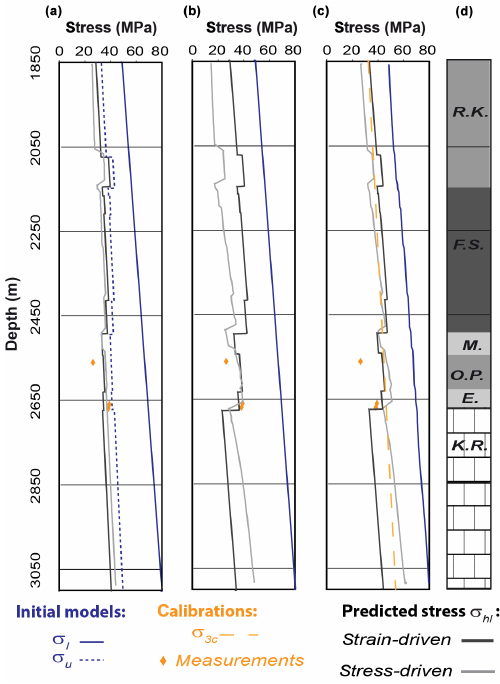
Figure 6. Comparison of the stress- and strain-driven models. Stress predictions for the stress-driven and the strain-driven models for (a) predictive strategies 1 and 5, based on the uniaxial stress and in situ stress measurements; (b) predictive strategies 2 and 6, based on the lithostatic stress and in situ stress measurements; and (c) pre- dictive strategies 4 and 8, based on the lithostatic stress and critical model. Also shown are the initial uniaxial stresses σ u (a) , the initial lithostatic stresses σ l (a–c) , and the critical stresses σ 3c (c) . (d) Sim- plified stratigraphic column of the studied area with the same legend as for Figs. 4 and